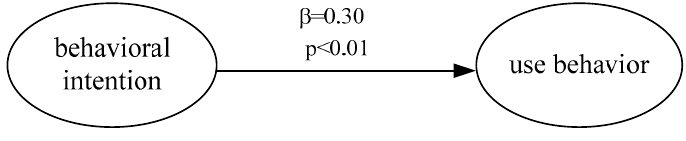
Figure 5. Direct e ff ect of behavioral intention on use Figure 5. Direct effect of behavioral intention on use behavior. Figure 5. Direct effect of behavioral intention on use behavior. Figure 5. Direct effect of behavioral intention on use behavior.